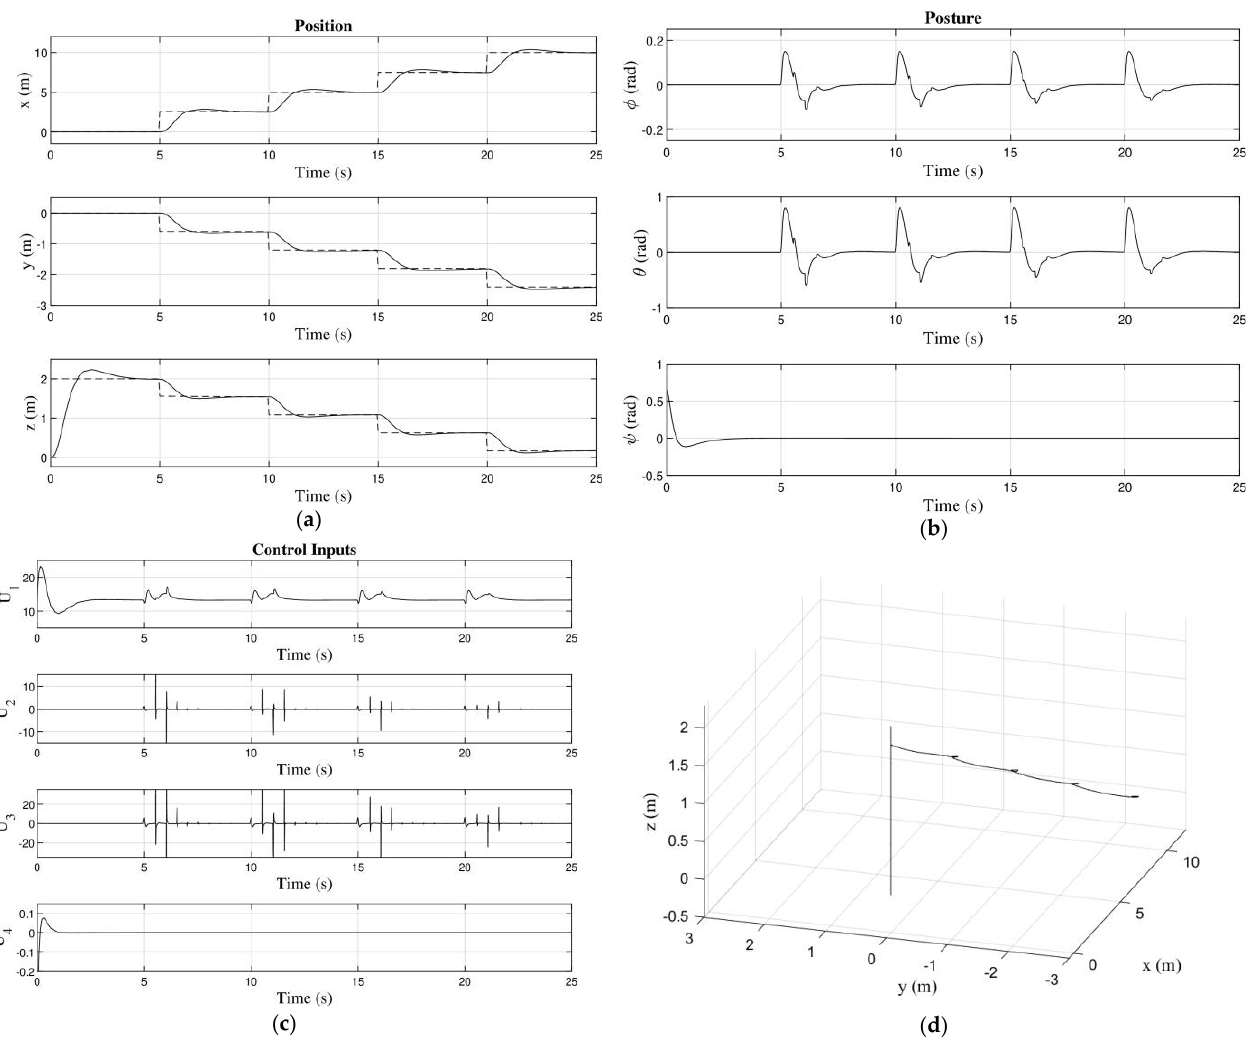
→ f is used as a reference: 12